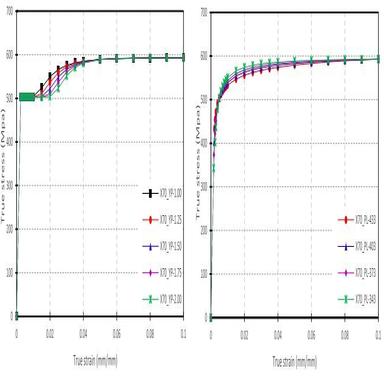
Idealized variations for stress–strain curves of X70-YPT and X70-RHT materials.